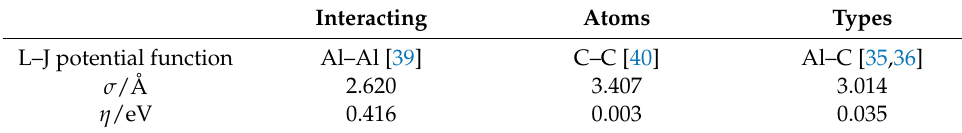
Table 1. Lennard–Jones (L–J) potential parameter for atomic interactions.